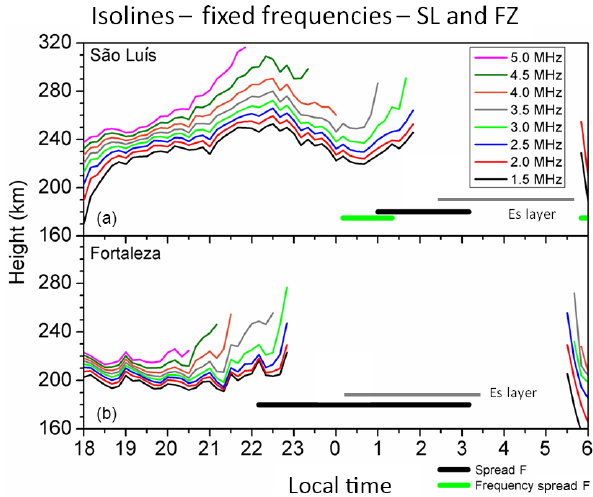
Figure 7. Oscillations in the real height of the F layer at fixed fre- quencies (1.5 to 5.0MHz) before the spread F in São Luís (a) and Fortaleza (b)